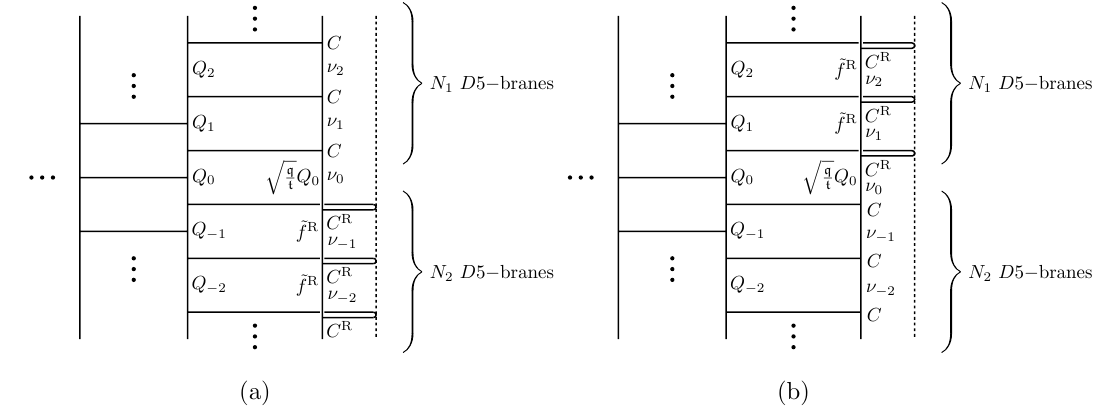
Figure 8 . 5-brane configurations for general D -type quiver gauge theory with an ON-plane located on the right.